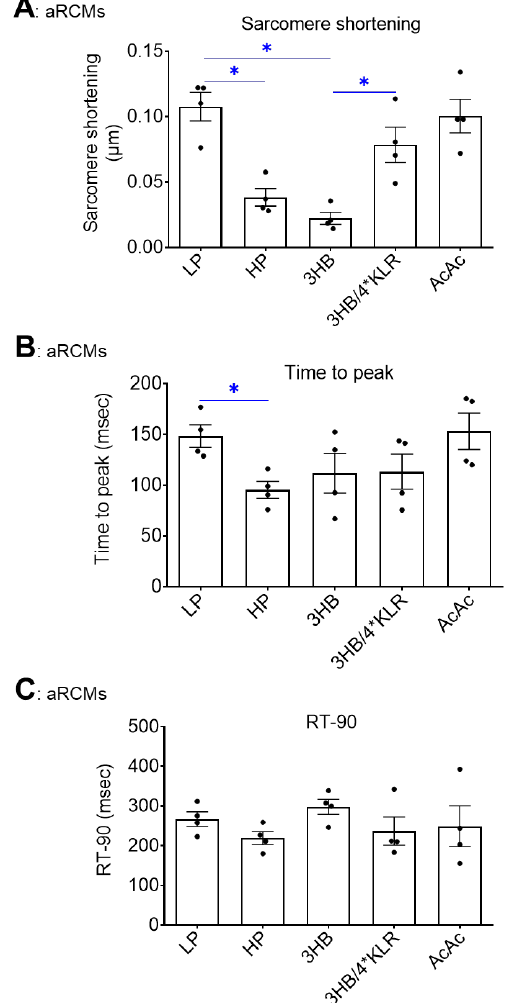
Figure 5. Chronic 3HB exposure induces contractile dysfunction in cardiomyocytes. ARCMs were cultured for 24 h under various conditions, being low palmitate medium (LP; control condition), high palmitate medium (HP), LP with 3 mM 3HB (3HB) or 3 mM acetoacetate (AcAc), and LP with 3HB in the presence of 4*KLR (3HB/4*KLR). The contractile parameters ( A ) sarcomere shortening, ( B ) time to peak and ( C ) decay time were deduced during electrostimulation at 1 Hz frequency (n = 4; imaging of 10 cells/measurement condition). Bar values are means ± SEM. * p < 0.05. The dots represent the measurements that are performed under ‘basal’ condition. The triangles represent the measurements that are performed after insulin stimulation.